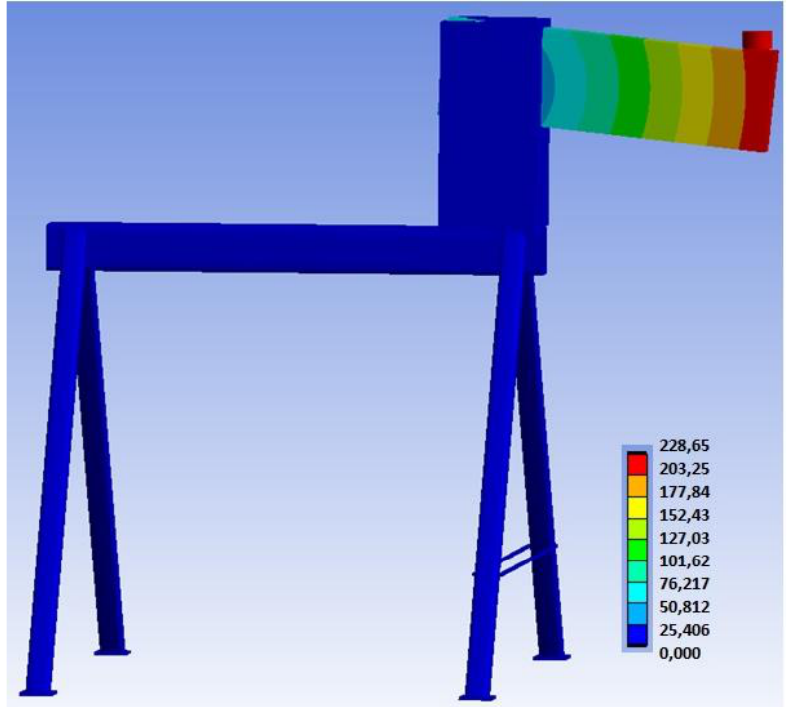
Figure 26. Overall deformation of the structure (mm) for Experiment B.